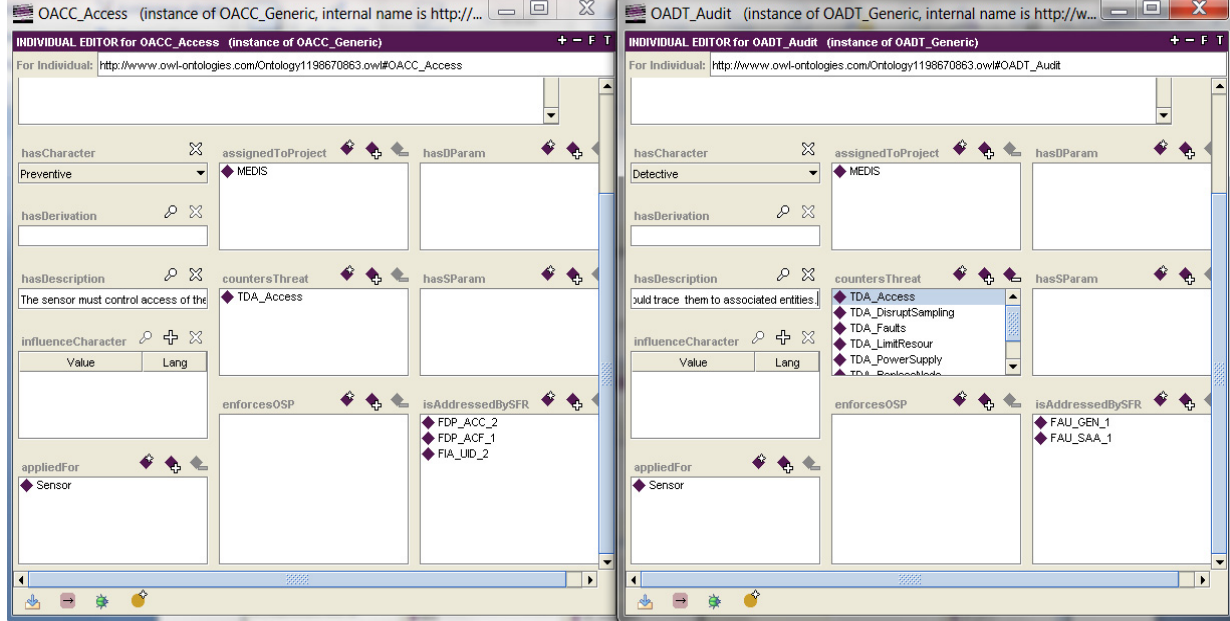
Figure 6. Specifying the functional security requirements for the security objectives using the tool [5].